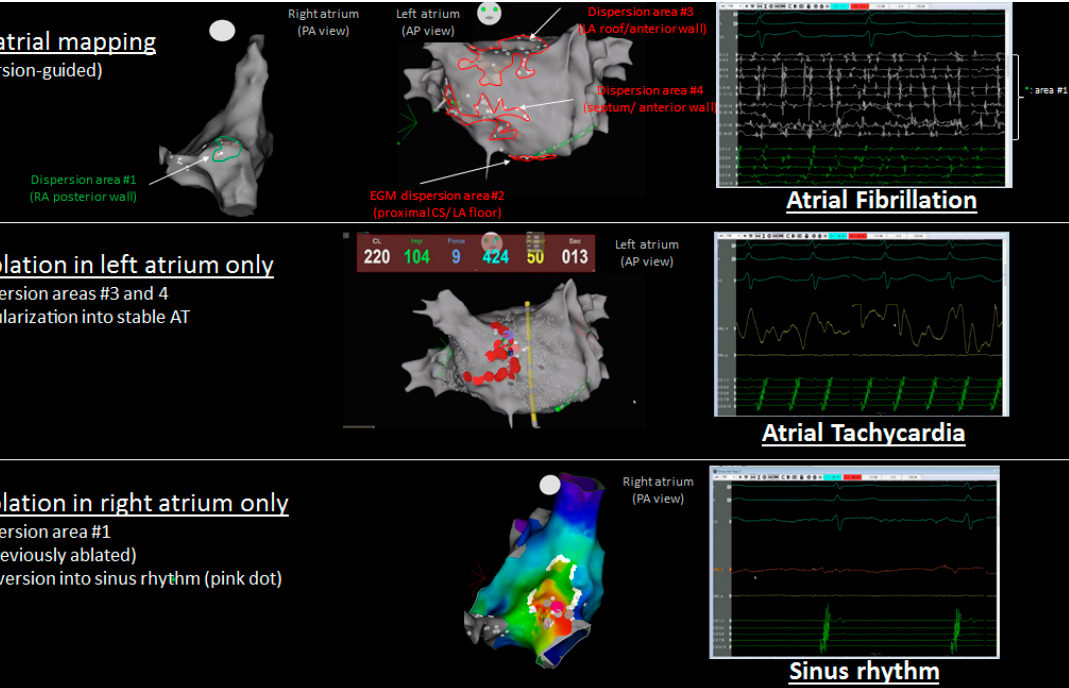
Figure 4. Representative example of the spatial concordance between spatiotemporal dispersion regions in persistent AF and a post-ablation localized AT emanating from the RA posterior wall, remotely from previously ablated regions. ( A ) Biatrial map showing spatiotemporal dispersion regions as encircled clusters of white dots, with the green and red lines indicating the RA and LA, respectively. ( B ) Ablation at dispersion regions in the LA led to AF regularization into a stable AT. ( C ) The localized AT presented in ( B ) terminated after ablation in the right atrium remotely from the closest ablation lesion. AF, atrial fibrillation; AT, atrial tachycardia.